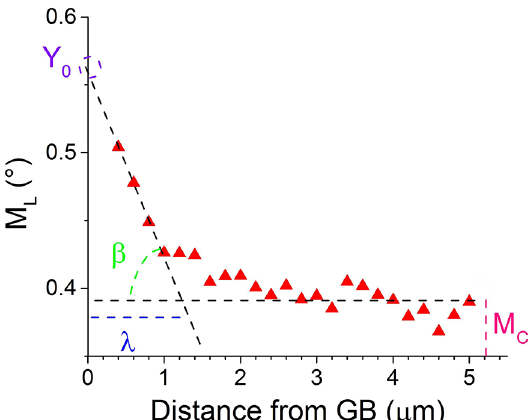
Figure 4. Misorientation profile through a particular GB in EZ after the 300 s test showing β, λ, Y